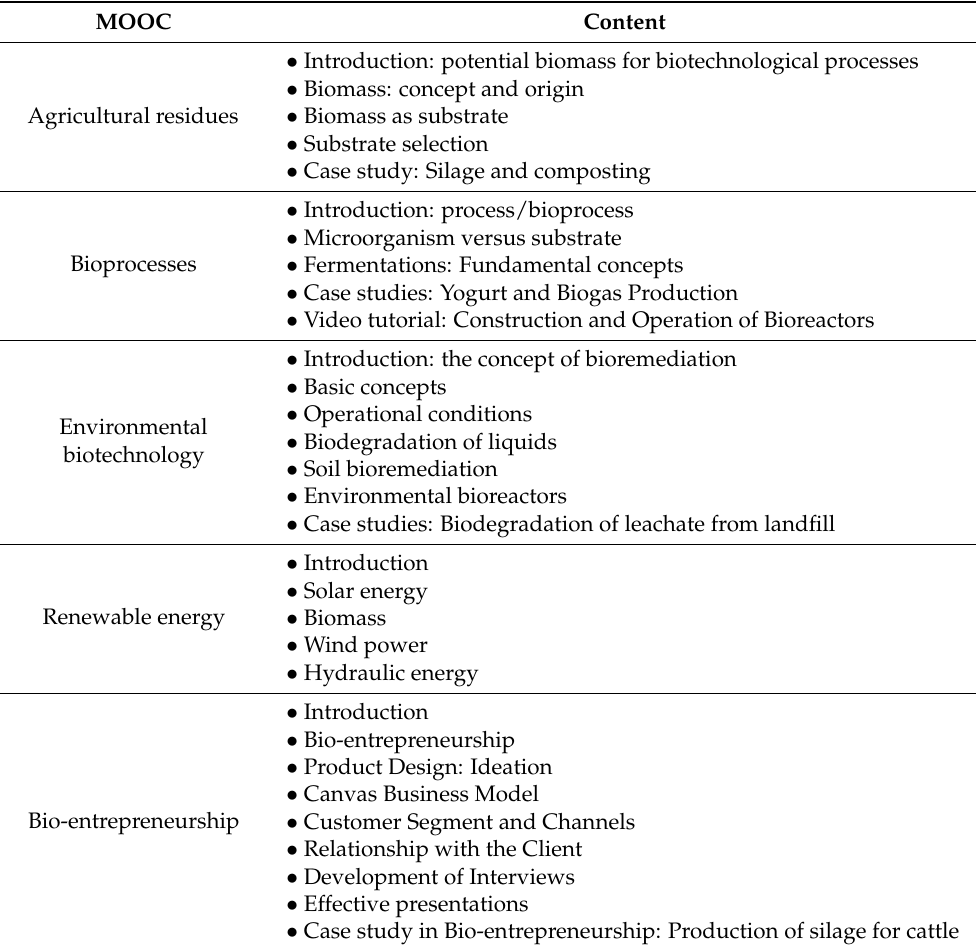
Table 3. Description of the Open Biotec MOOC courses.